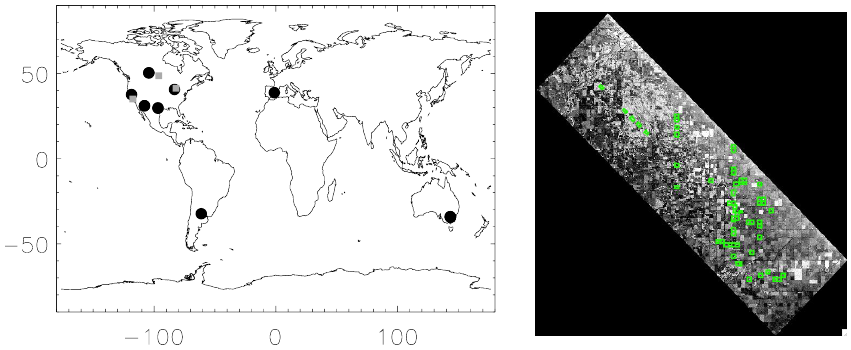
Figure 2. ( left ) locations of the 14 SMAP core validation sites (circle), and airborne/ground sites in California, Michigan, and Manitoba (grey square). Several SMAP sites are close to each other and appear as a single dot; ( right ) field locations from SMAPVEX12 campaign: green rectangles overlaid on 25 × 60 km 2 UAVSAR image. Table 1. List of datasets.